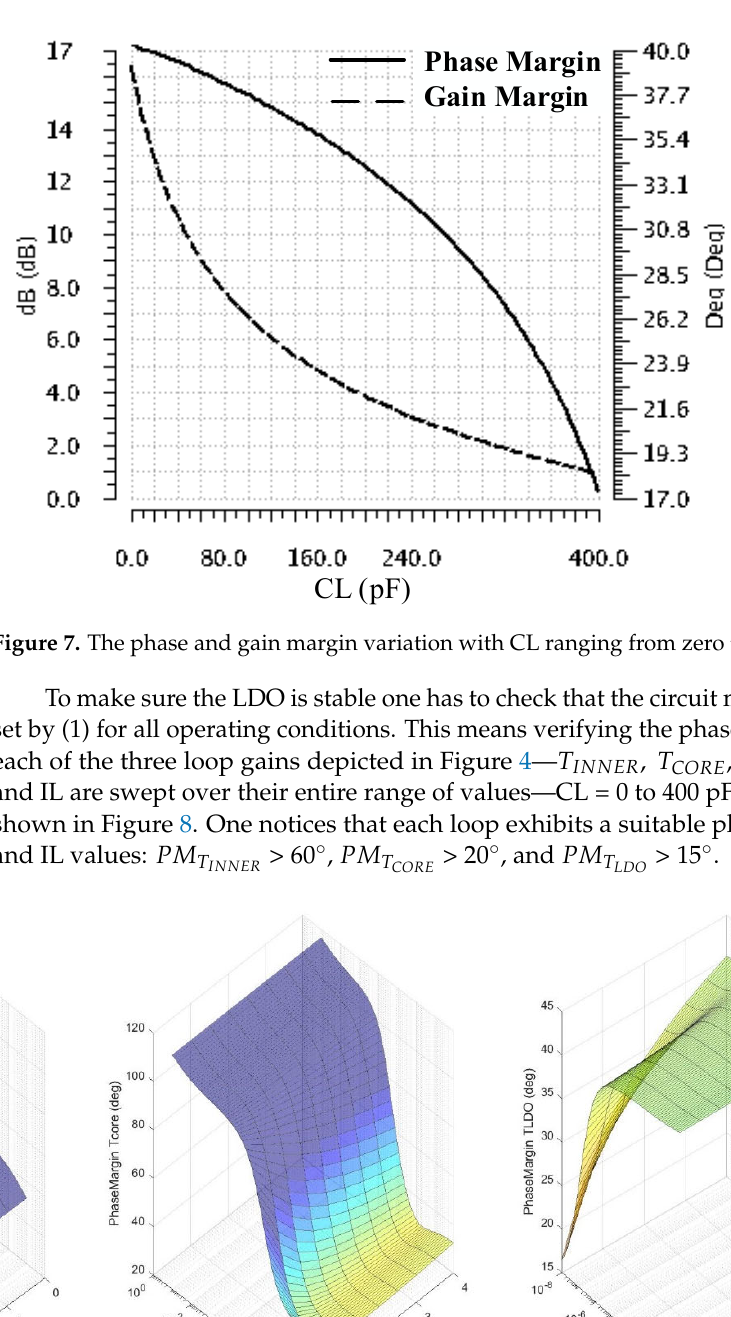
17° @ IL=0A Figure 6. The frequency characteristics of the LDO loop gain, (cid:1846) (cid:3013)(cid:3005)(cid:3016) , for CL = 0 F ( left ) and 400 pF ( right ) and extreme IL values: 0 mA and 100 mA. Figure 7 presents the variation of (cid:1846) (cid:3013)(cid:3005)(cid:3016) phase and gain margins with the CL value for the no ‐ load ‐ current operation. It indicates that, as the value of the load capacitor increases, the phase margin monotonically decreases, reaching a minimum of 17° for CL